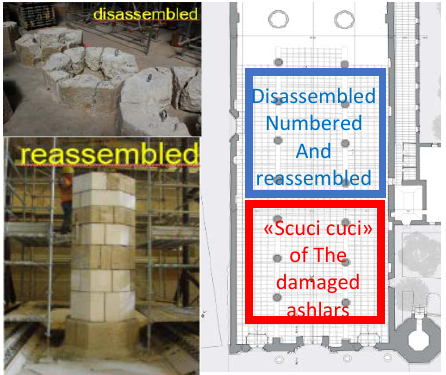
Figure 11. The two different conservation